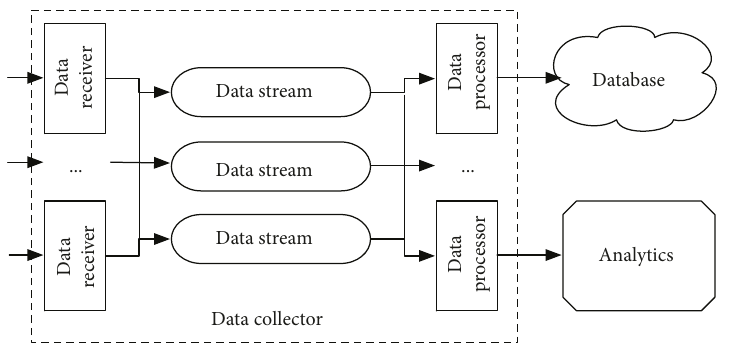
Figure 5: Data collectors in the extended sensor data back-end architecture.